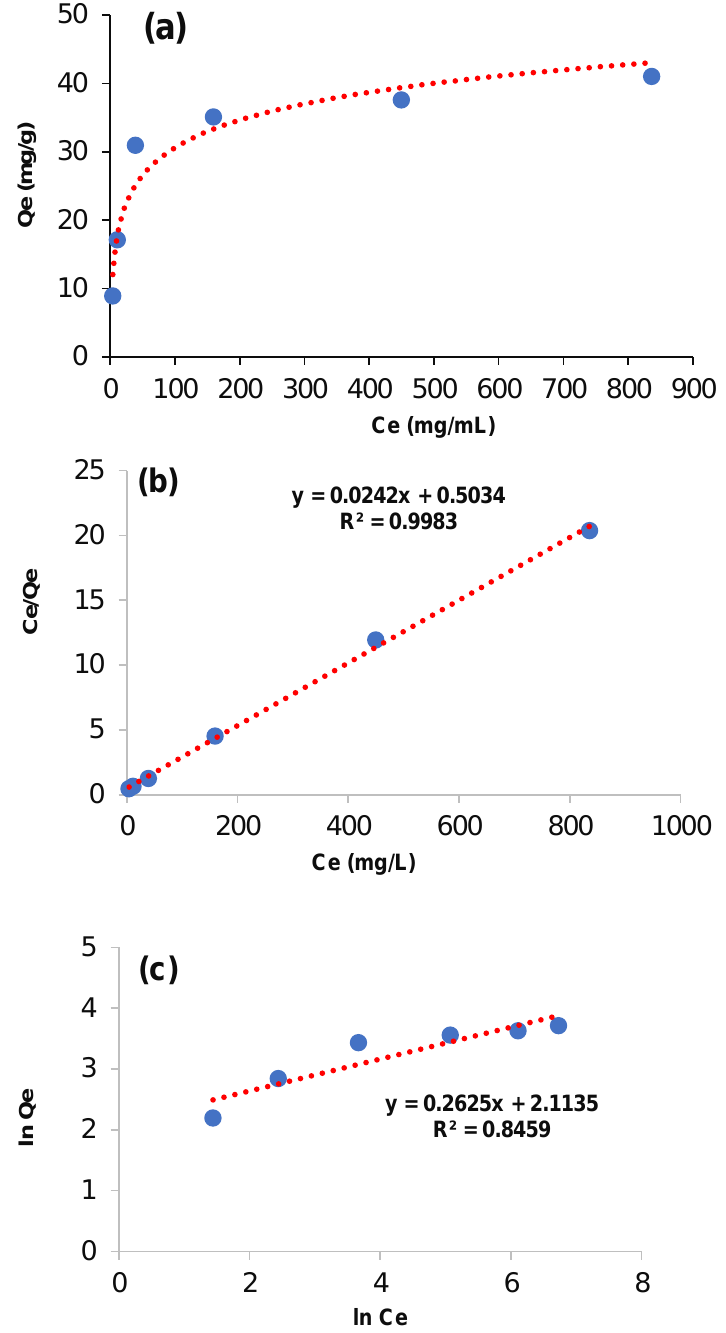
Figure 10. Isotherm models of ( a ) initial concentration and on equilibrium adsorption capacity (con- dition: pH 5, 80 mg adsorbent, and 20 mg.L -1 arsenic). Linear models of ( b ) Langmuir isotherm and